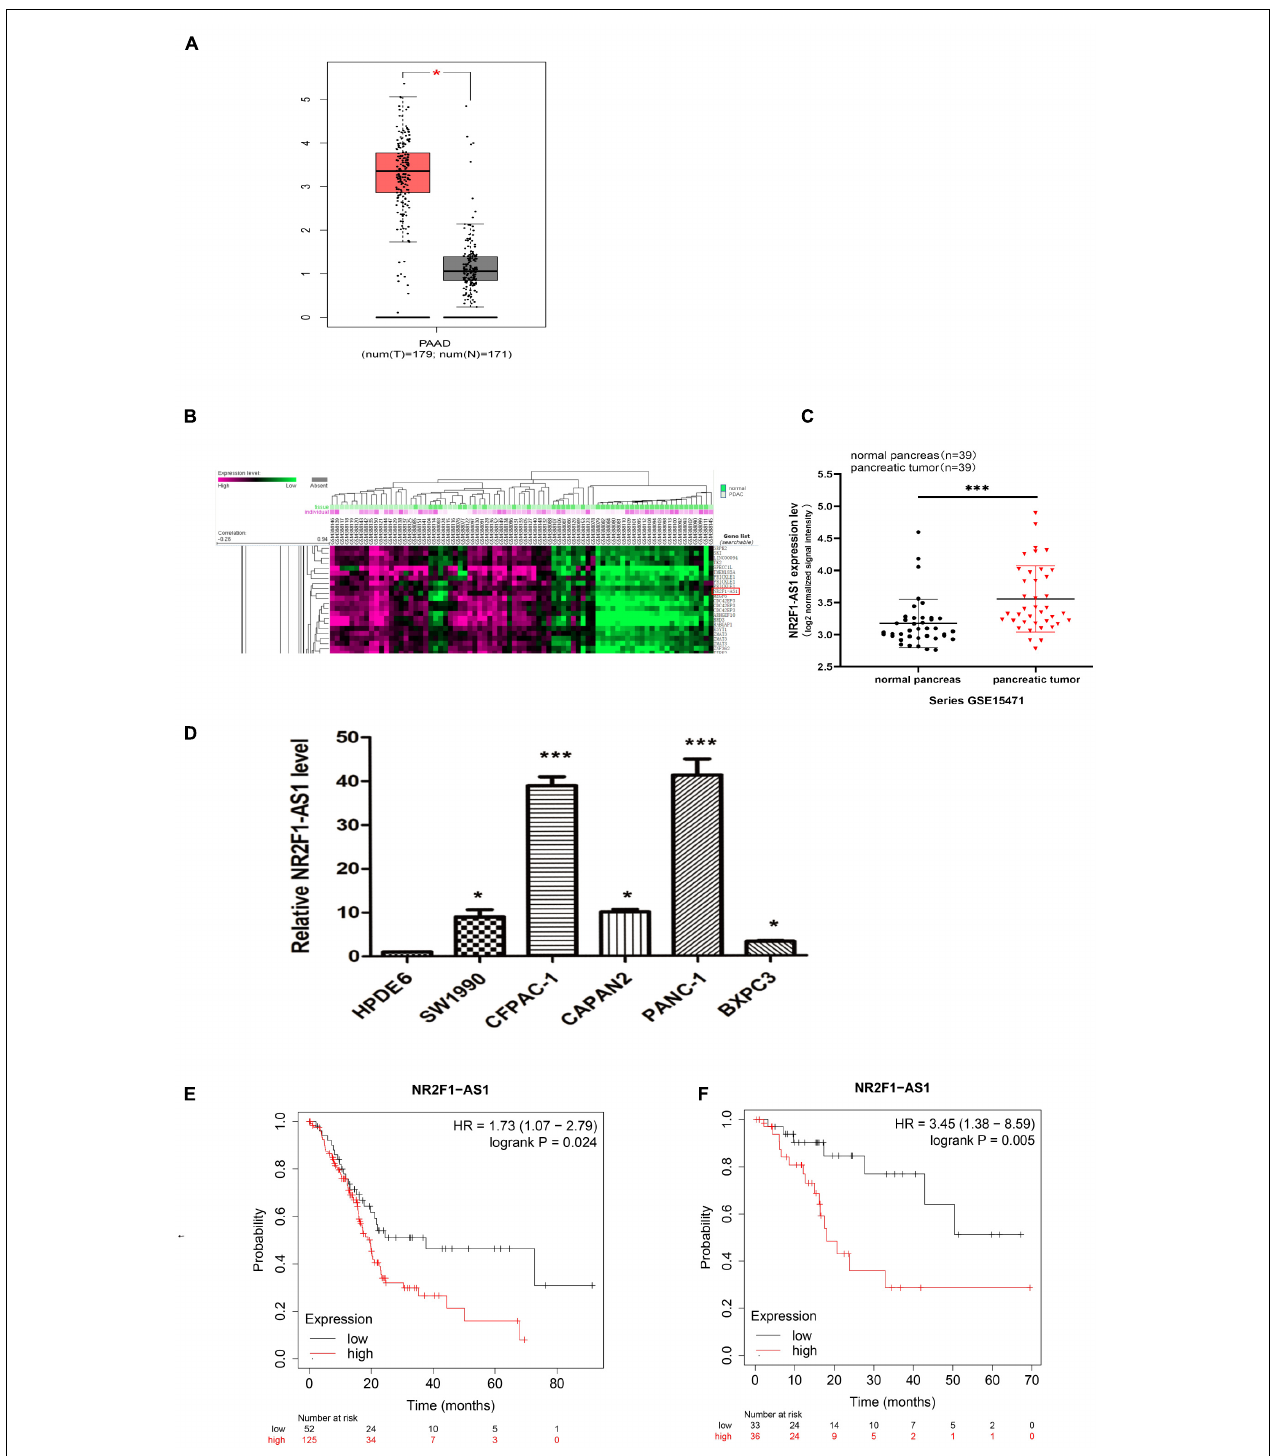
FIGURE 1 | NR2F1-AS1 is upregulated in PDAC and correlated with poor prognosis. (A) Boxplots comparing NR2F1-AS1 expression in PDAC samples ( n = 179) and normal pancreatic tissue samples ( n = 171). (B) Heatmap showing differentially expressed lncRNAs in the GEO dataset of GSE5471. (C) Microarray data from the GEO dataset GSE5471 were used to analyze the relative expression of NR2F1-AS1 in PDAC and adjacent normal tissue. (D) Relative expression levels of NR2F1-AS1 in PDAC cell lines. (E,F) Correlation analysis of NR2F1-AS1 expression with overall survival (OS) and recurrence-free survival (RFS) in PDAC patients obtained from the Kaplan–Meier plotter database. The P value was calculated by a log-rank test. HR, hazard ratio. Statistical significance: * p < 0.05 and *** p < 0.001.